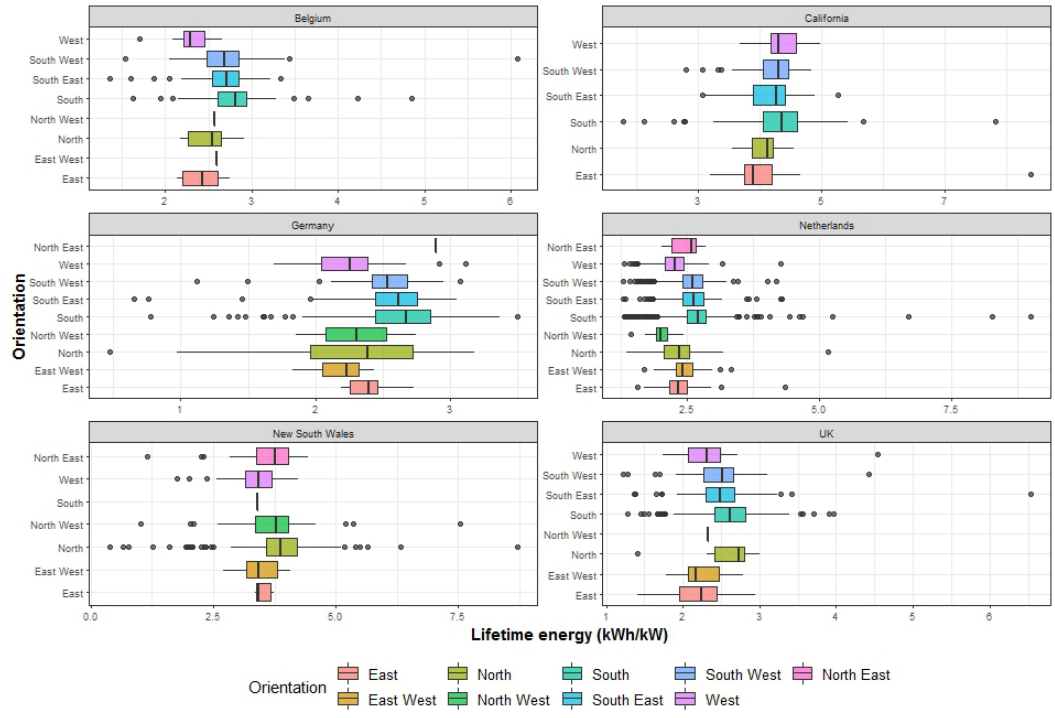
Figure 2. The lifetime yield distribution of PV systems in non-shading group.